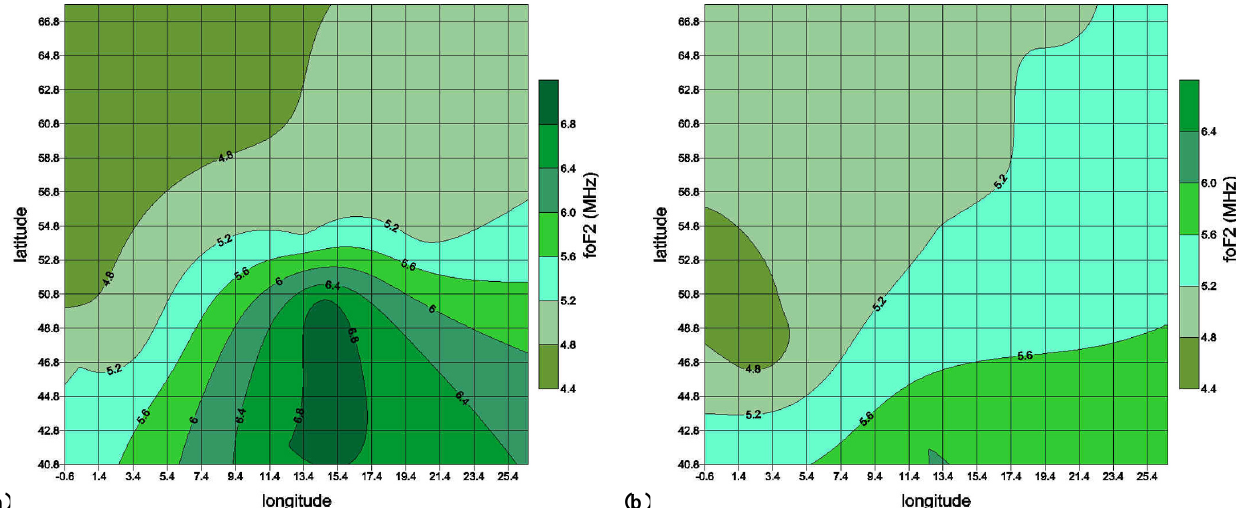
Fig. 2. (a) Map obtained from fo F2 measurements and (b) forecasting map for fo F2 two hours in advance generated using the IFERM model